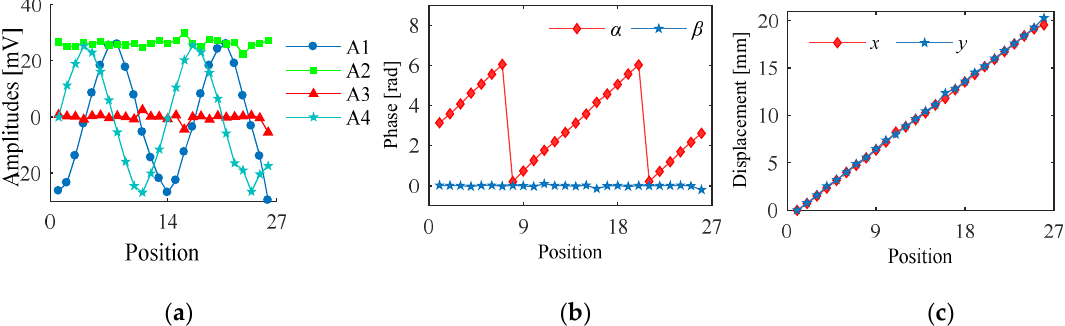
Figure 8. Calculation results based on the algorithm. ( a ) Amplitudes of S 1 ~ S 4 that vary with displacements. ( b ) Variations of α and β . ( c ) Calculation results of x and y .